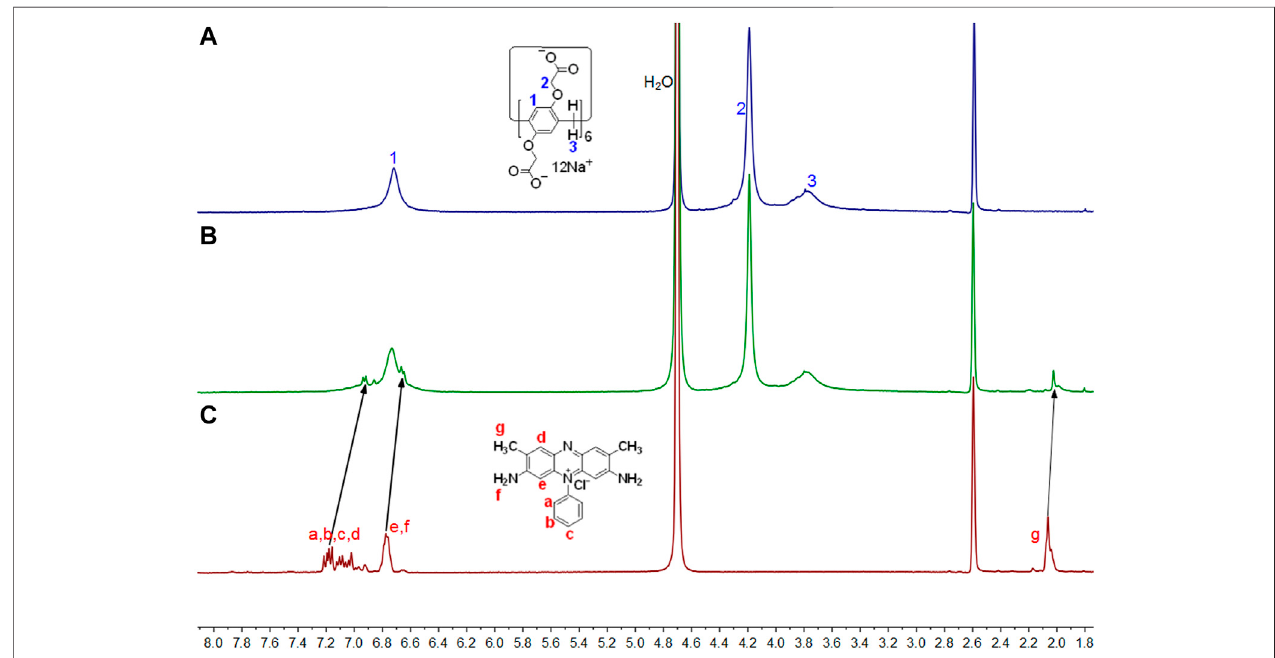
Frontiers in Chemistry |